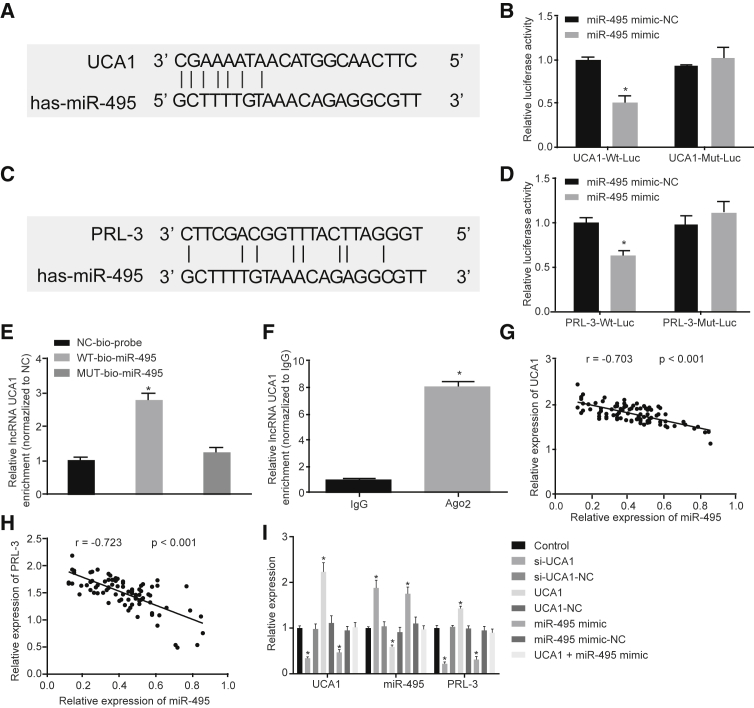
UCA1 Competitively Binds to miR-495 to Upregulate PRL-3(A) The targeting relationship between UCA1 and miR-495 predicted by the bioinformatics website. (B) The targeting relationship between UCA1 and miR-495 verified by dual-Luc reporter gene assay. (C) The targeting relationship between PRL-3 and miR-495 predicted by the bioinformatics website. (D) The targeting relationship between PRL-3 and miR-495 verified by dual-Luc reporter gene assay. (E) miR-495 binds to UCA1 by RNA pull-down assessment. (F) miR-495 binds to UCA1 by RIP assay. (G) miR-495 was negatively correlated with UCA1. (H) PRL-3 was negatively correlated with miR-495. (I) Expressions of UCA1, miR-495, and PRL-3 detected by qRT-PCR in each group. *p < 0.05, versus the other three groups in (B) and (E), versus the Bio-NC probe-labeled group in (C), versus the IgG group in (F), and versus the control group in (G) (comparisons between two groups were made using paired t test; comparisons of measurement data among multiple groups were analyzed by one-way ANOVA; each experiment was conducted three times independently).